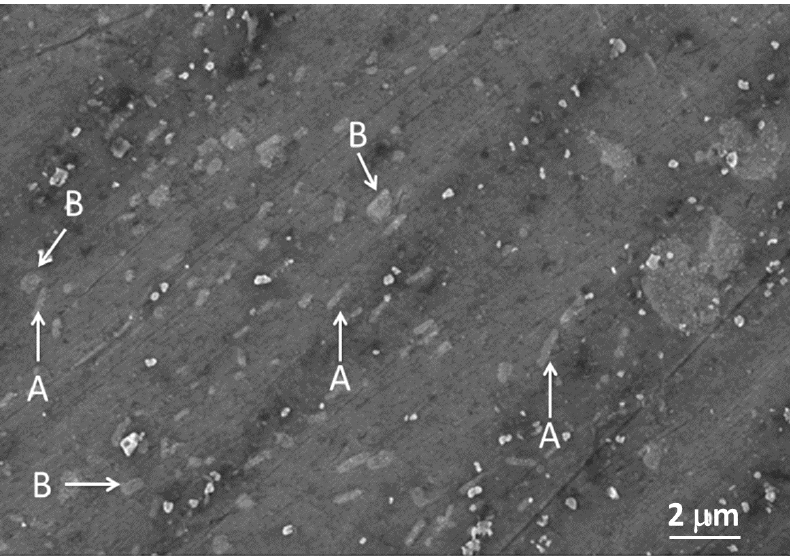
Figure 6. FESEM morphology of Mg 2 Sn phase in the form of lathe/rod ( A ) and polygon ( B ) in the Mg-3Sn + 0.2 GNP alloy-nanocomposite.